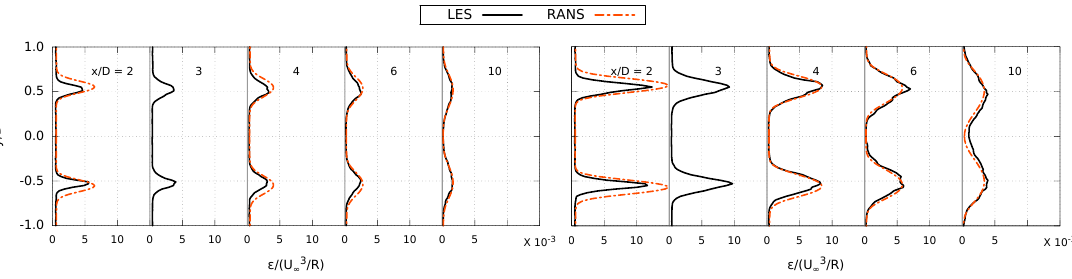
Figure 9. Vertical profiles of ε behind the disk C T = 0.42 ( left ) and C T = 0.62 ( right ), Ti3